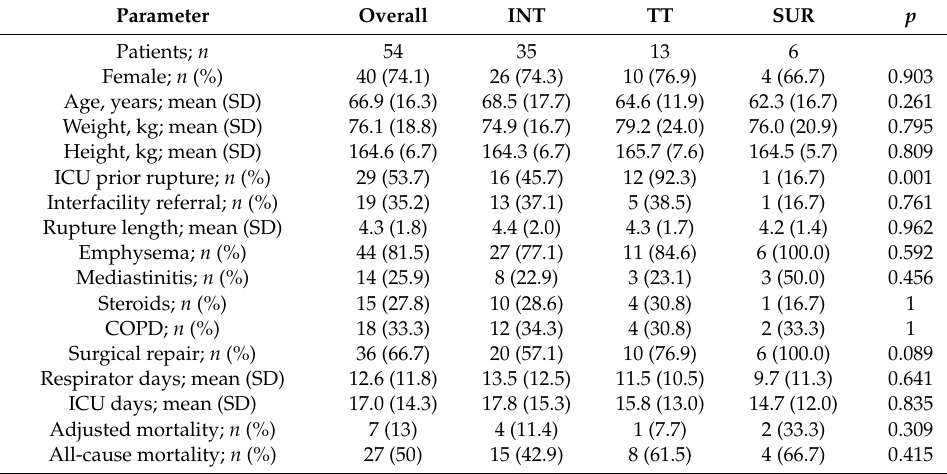
Table 1. Comparison of characteristics between di ff erent causative